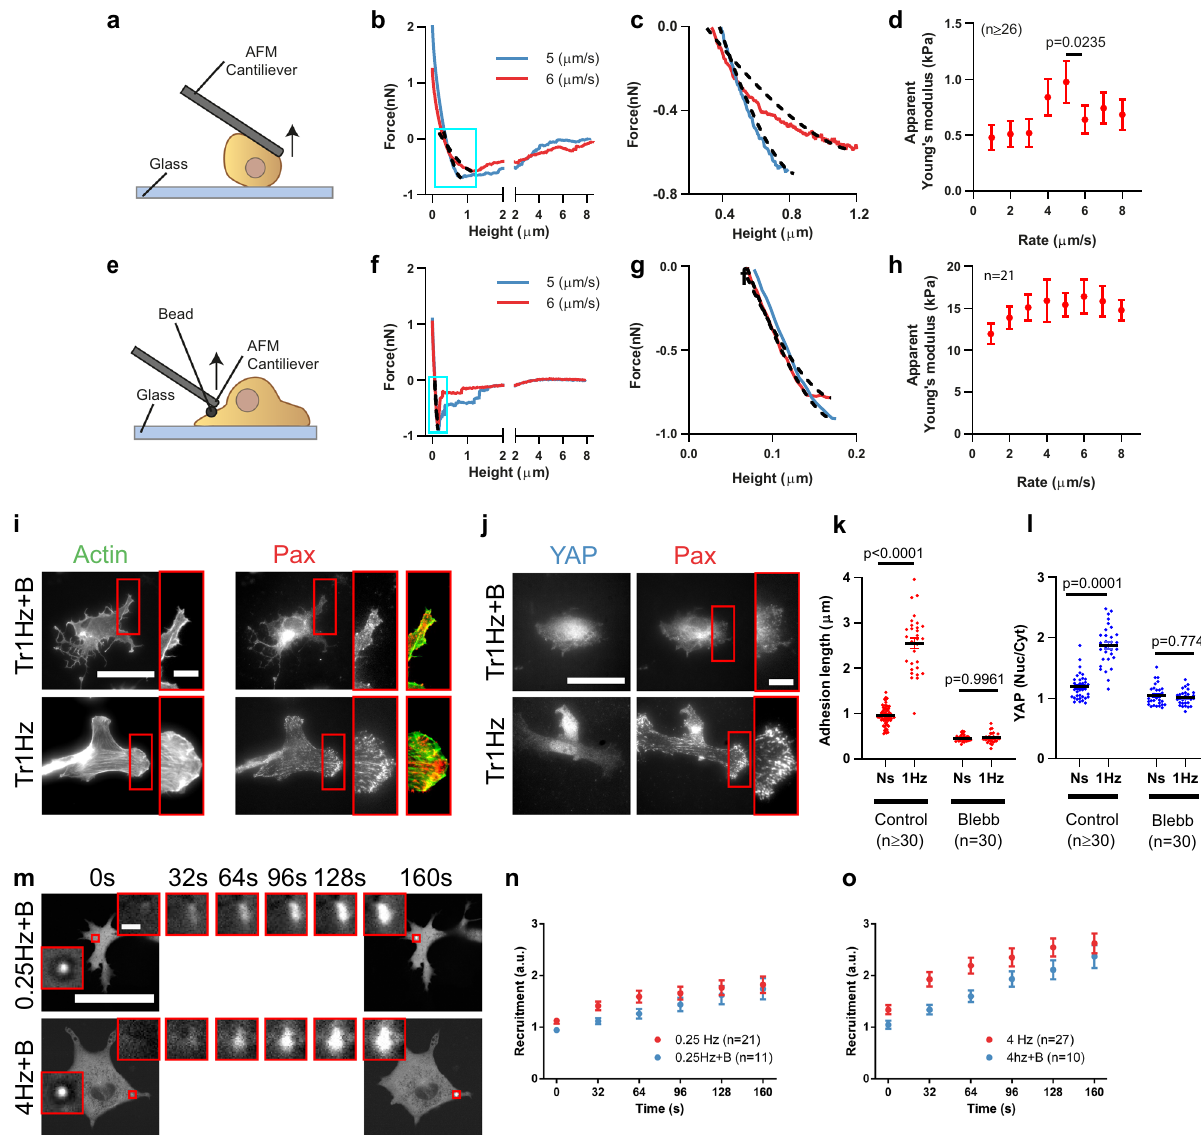
Fig. 4 High deformation rates lead to cytoskeletal softening. a Illustration of the single-cell AFM setup. b Example cantilever retraction curves of the single-cell AFM experiments. Dashed lines within blue squares show the fi ts of the force/deformation curves used to calculate apparent cell stiffness (Young ’ s modulus). Curves were fi tted between the beginning of cell stretch (below zero force) and the point at which cells start detaching (minimum force in the curve). c Magni fi cation of the curve section fi tted in b . d Stiffness as a function of the retraction speed for cells attaching to a fi bronectin-coated substrate. The effect of retraction speed ( p < 0.0001), and the speci fi c decrease from 5 to 6 µ m/s ( p = 0.0235) were signi fi cant. n numbers are curves. Statistical signi fi cance was assessed with Friedman test. e Illustration of the bead AFM setup. f Example cantilever retraction curves of bead AFM experiments. g Magni fi cation of the curve section fi tted in f . h Stiffness as a function of the retraction speed for fi bronectin-coated beads attaching to cells. The effect of retraction speed was not signi fi cant (Friedman test). n numbers are curves. i , j Actin and paxillin ( i ) and YAP and paxillin ( j ) stainings for cells stretched by 10% with a triangular 1 Hz signal, with or without blebbistatin treatment. Scale bar is 50 µ m (10 µ m in magni fi cations). k , l Corresponding quanti fi cations of adhesion length ( k ) and YAP nuclear to cytosolic ratios ( l ). n numbers are cells. Statistical signi fi cance was assessed with two-way ANOVA. m Images of blebbistatin-treated cells transfected with GFP-paxillin during force application with triangular signals at 0.25 and 4 Hz, shown as a function of time. Areas circled in red are shown magni fi ed at different timepoints. Scale bar is 50 µ m (2 µ m in magni fi cations). n , o Corresponding quanti fi cations of recruitment of GFP-paxillin at beads at 0.25 Hz ( n ) and 4 Hz ( o ). No signi fi cant effect of blebbistatin was observed (two-way ANOVA). n numbers are beads. Data are shown as mean ±